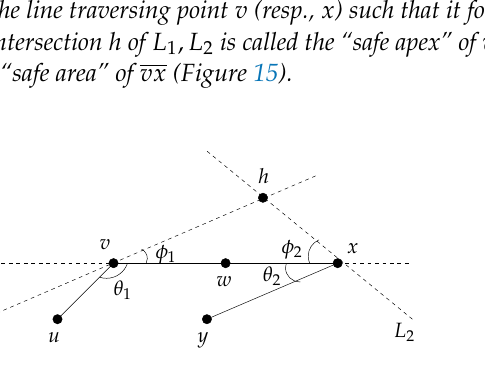
Figure 15. An illustration of safe apex and safe area.